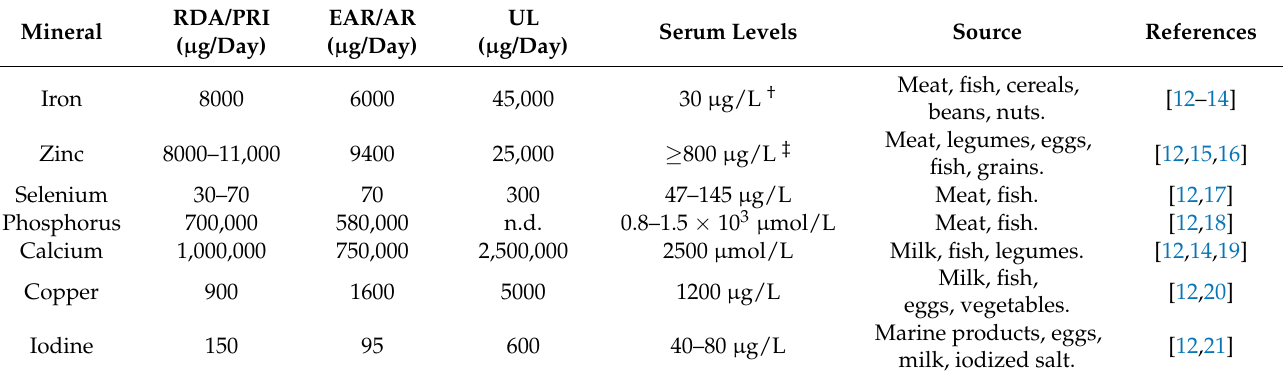
Table 1. Recommended daily intakes and related serum levels of the minerals reported in the present review